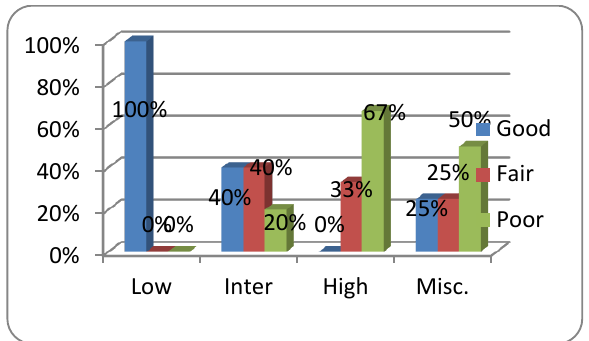
Figure 5: Development state of PR in ARM patients of various types.